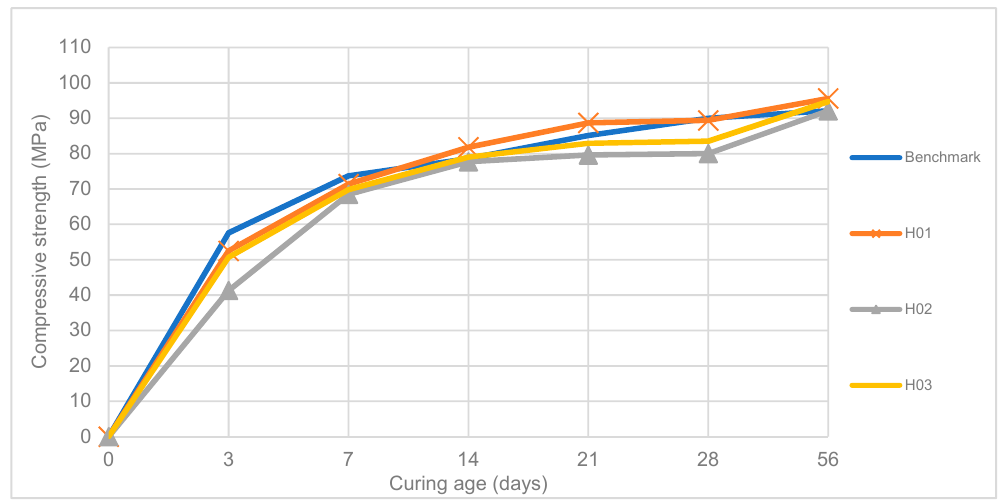
Figure 18. Compressive strength variation of hybrid SCC samples.